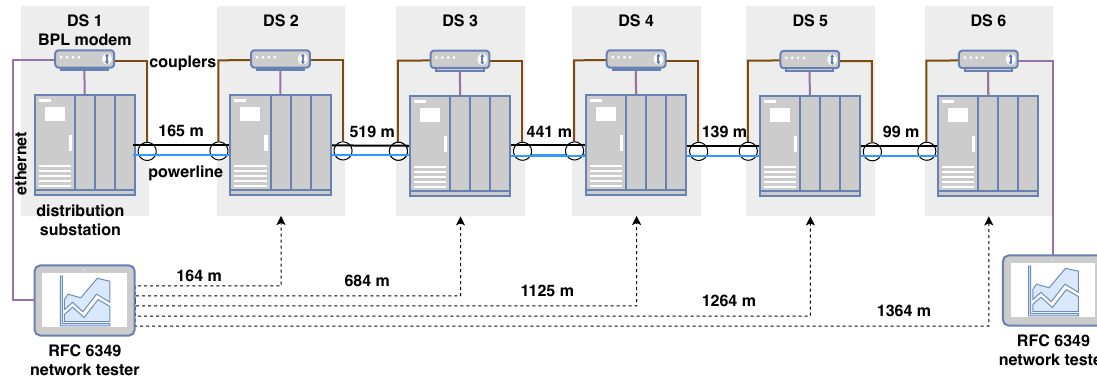
Figure 8. Simplified linear field topology with distances between communicating substations.